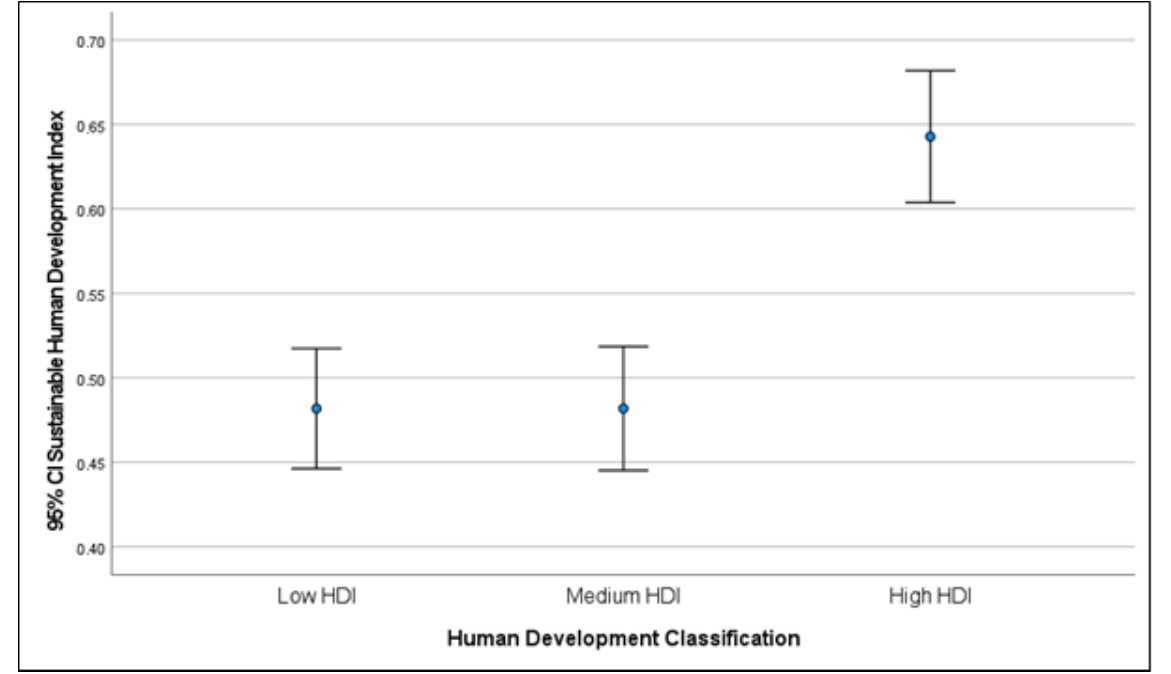
Figure 8. Error bar graph of the municipalities by classification of the HDIm.